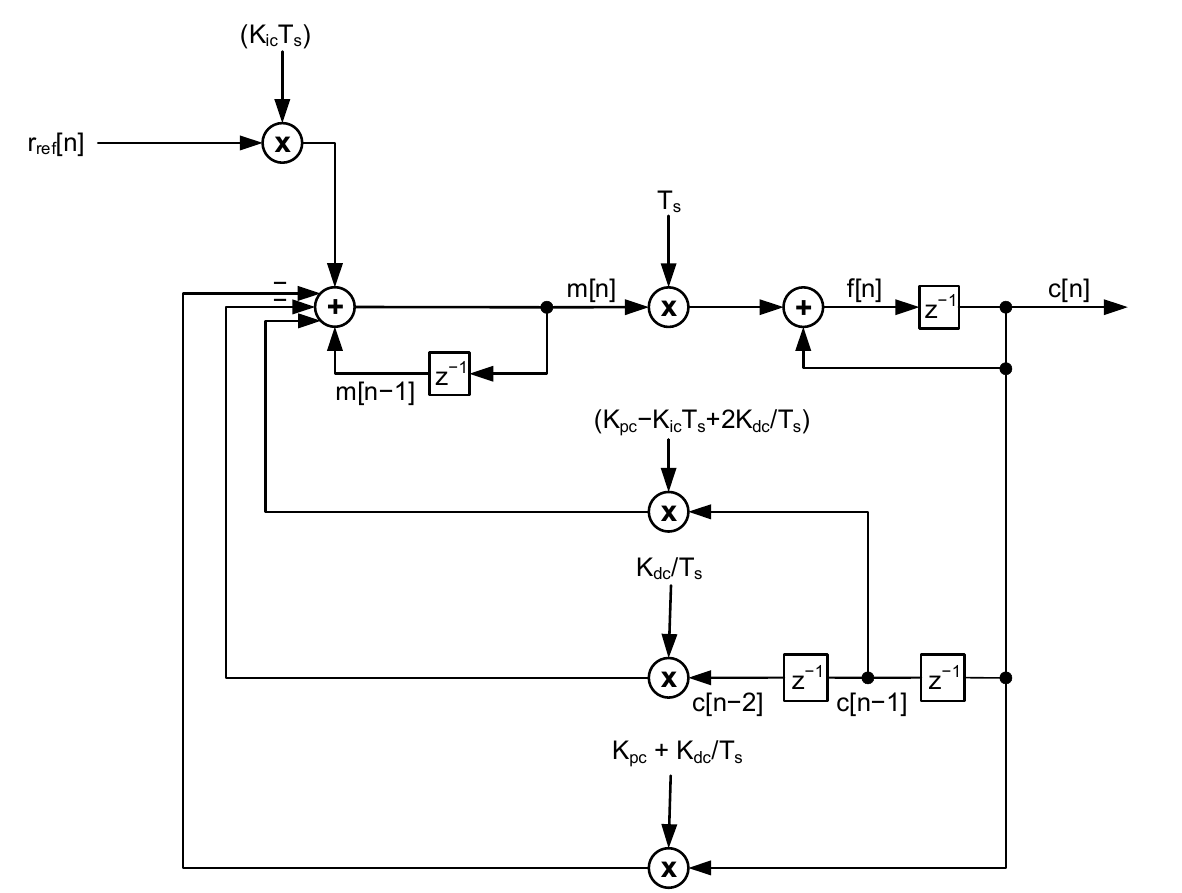
Figure 19. Implementation of system with Velocity Form PID ready for analysis in Z.